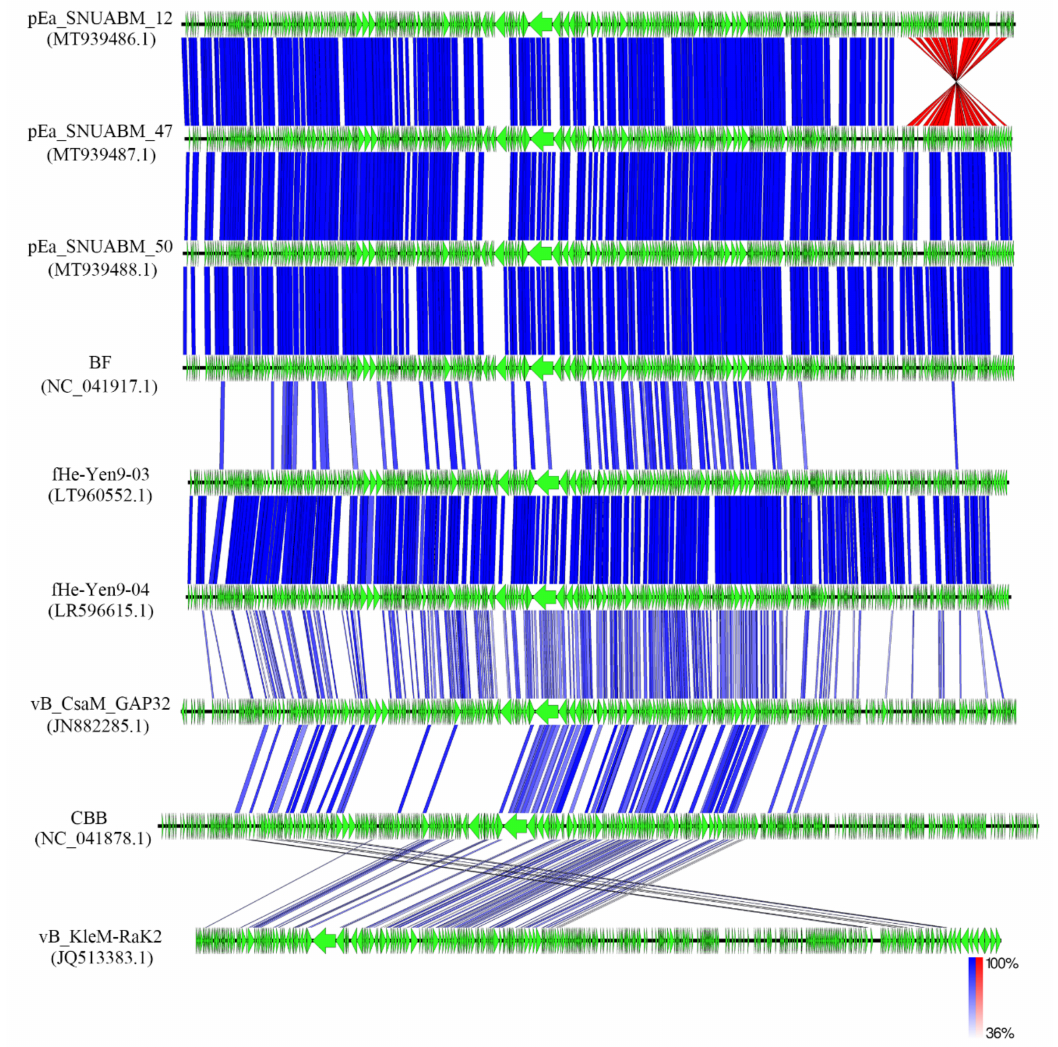
Figure 2. Comparative whole genome analysis of Erwinia phages pEa_SNUABM_12, pEa_SNUABM_47, and pEa_SNUABM_50 and related jumbo phages. The analysis was performed with tBLASTx algorithm in